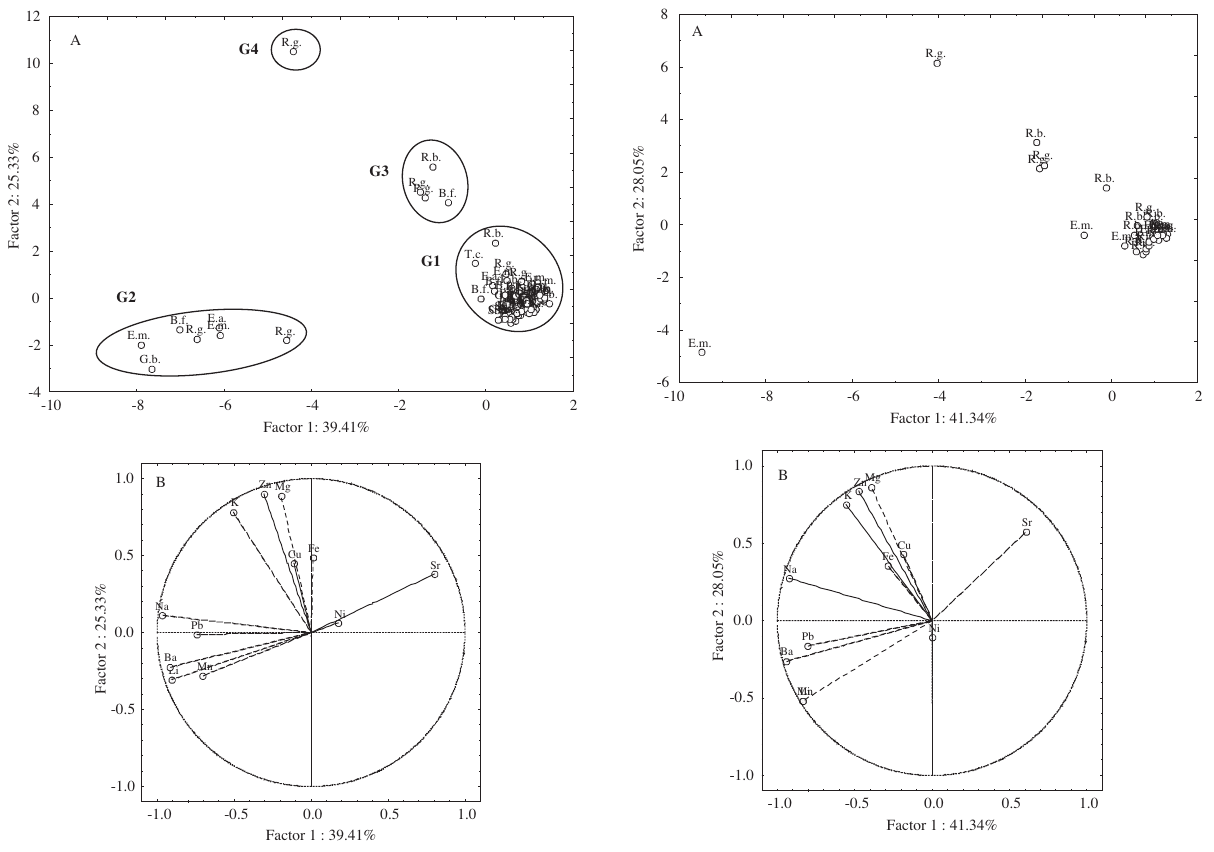
F IG . 4. – The grouping of 96 individuals of 10 species of gobies (A) F IG . 5. – The grouping of 34 individuals of the 4 species of classified by the relative contribution of the otolith element/Ca amphidromous larval gobies (A) classified by the relative contribu- ratios in the first two components of PCA (B). See Table 2 for tion of the otolith element/Ca ratios in the first two components of species abbreviations. PCA (B). See Table 2 for species